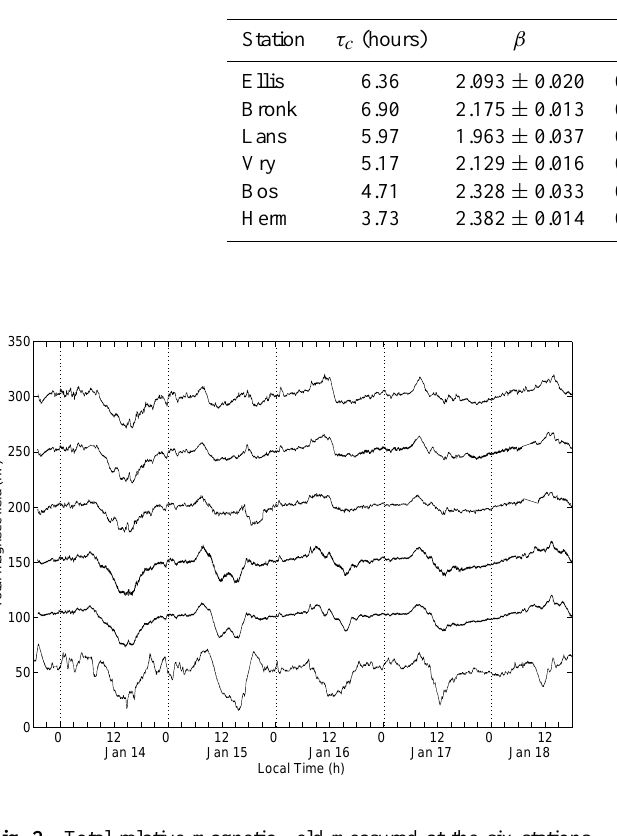
Table 2. For each station, the columns list the autocorrelation time, τ c ; the power spectral exponent, β ; the corresponding Hurst exponent, H β , calculated from β = 2 H β + 1; the Hurst exponent, H R/S , calculated by the R/S method; and the fractal dimension, D R/S , calculated from D R/S = 2 − H R/S . The error listed is that from the least-squares regression and so it is only a minimum error as there are other possible sources of error that are difficult to calculate. (The error of D R/S is the same as that for H R/S